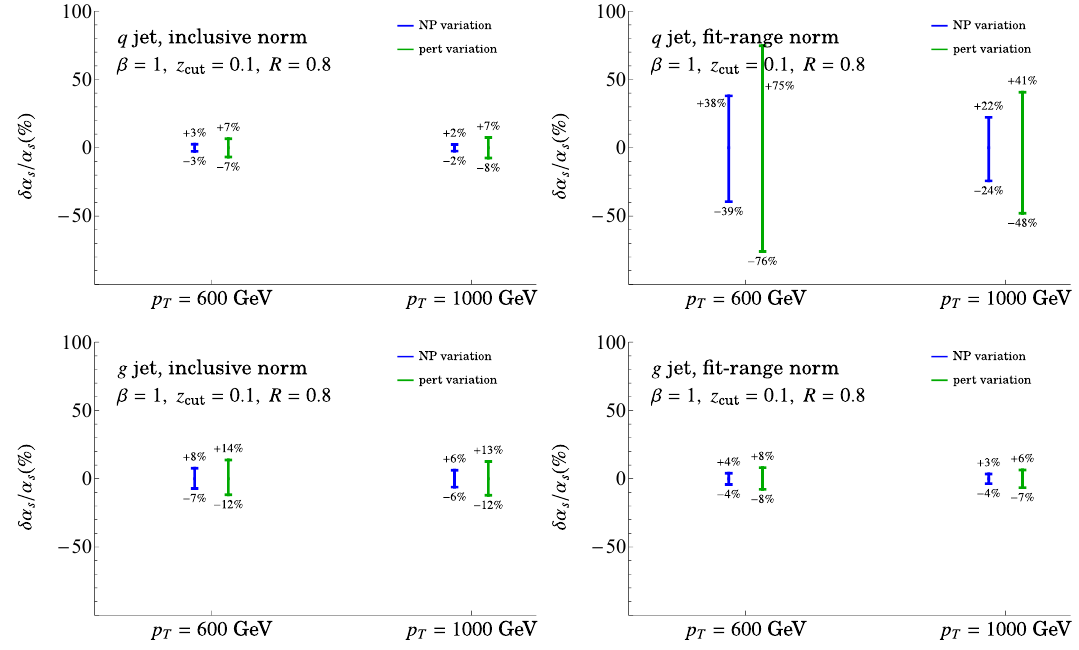
Figure 15 . Uncertainty in α s ( m Z ) due to profile variations and nonperturbative-parameter uncer- tainty, for different values of p , for the normalized soft-drop jet-mass cross T